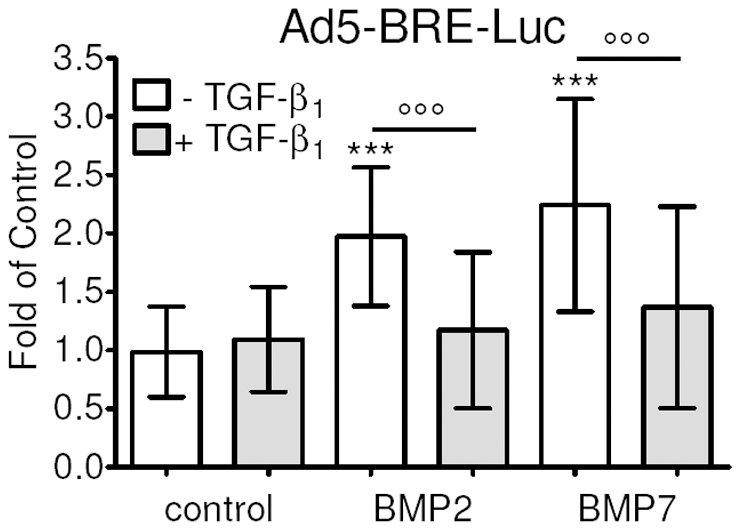
TGF-β1 suppresses BMP2 and BMP7 mediated Smad1/5/8 signaling in osteoblasts.Primary human osteoblasts infected with Ad5-BRE-Luc adenoviral particles (Smad1/4 reporter) were stimulated with 5 ng/ml hr TGF-β1 and/or 50 ng/ml hr BMP2 or -7. After 48 h luciferase activity was measured in cell lysates and normalized to total protein contents. BMP2 and -7 significantly induced Smad1/4 reporter signal by more than 2 fold. TGF-β1 showed now Smad1/4 reporter signal. Furthermore, in co-stimulation TGF-β1 even inhibited the observed BMP2 and -7 mediated Smad1/4 signaling. Results are expressed as mean ± standard deviation (N = 3, n = 6). ***p<0.001 versus untreated cells. °°°p<0.001.